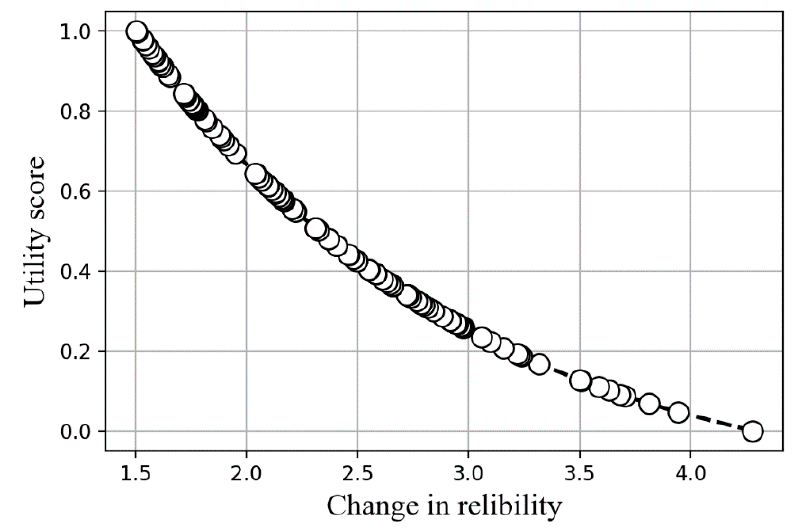
Figure 7. Utility plot of reliability benefit.